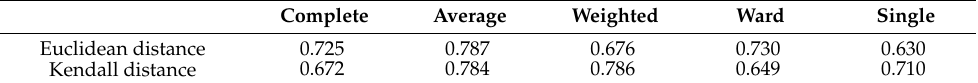
Table 2. The cophenetic coefficient of various linkage methods based on distance matrices. Complete